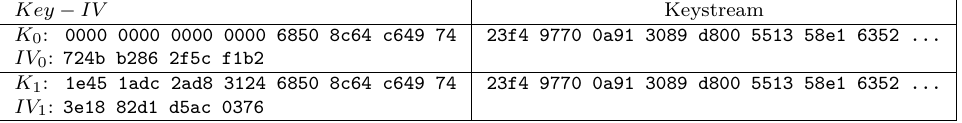
Table 1: Key-IV pairs that produce identical keystream